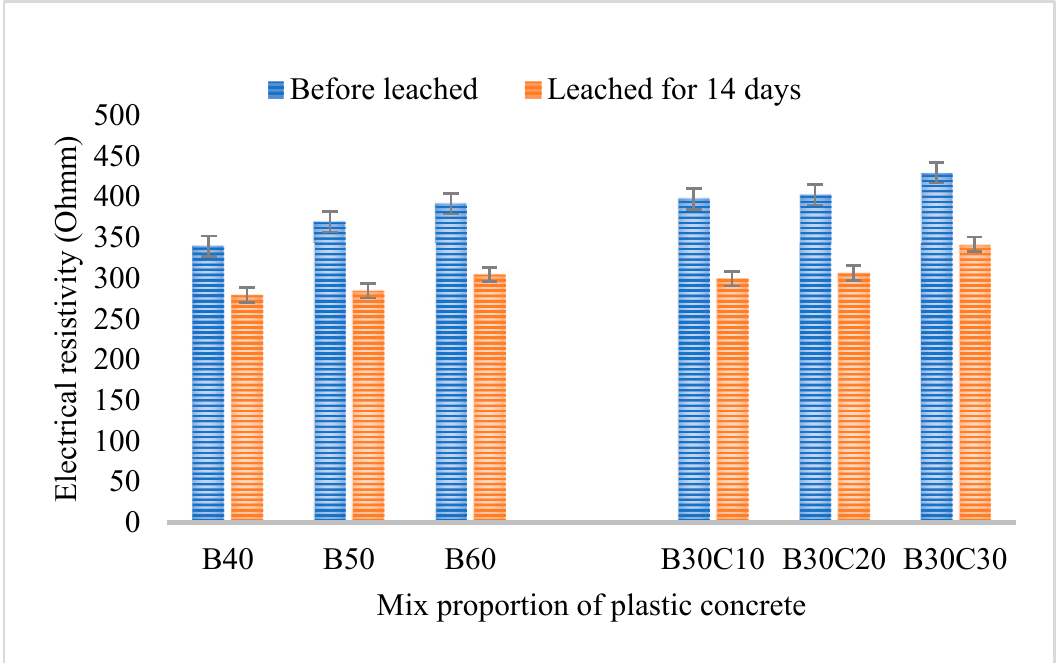
Figure 7. Variation of electrical resistivity of plastic concrete with leaching duration.